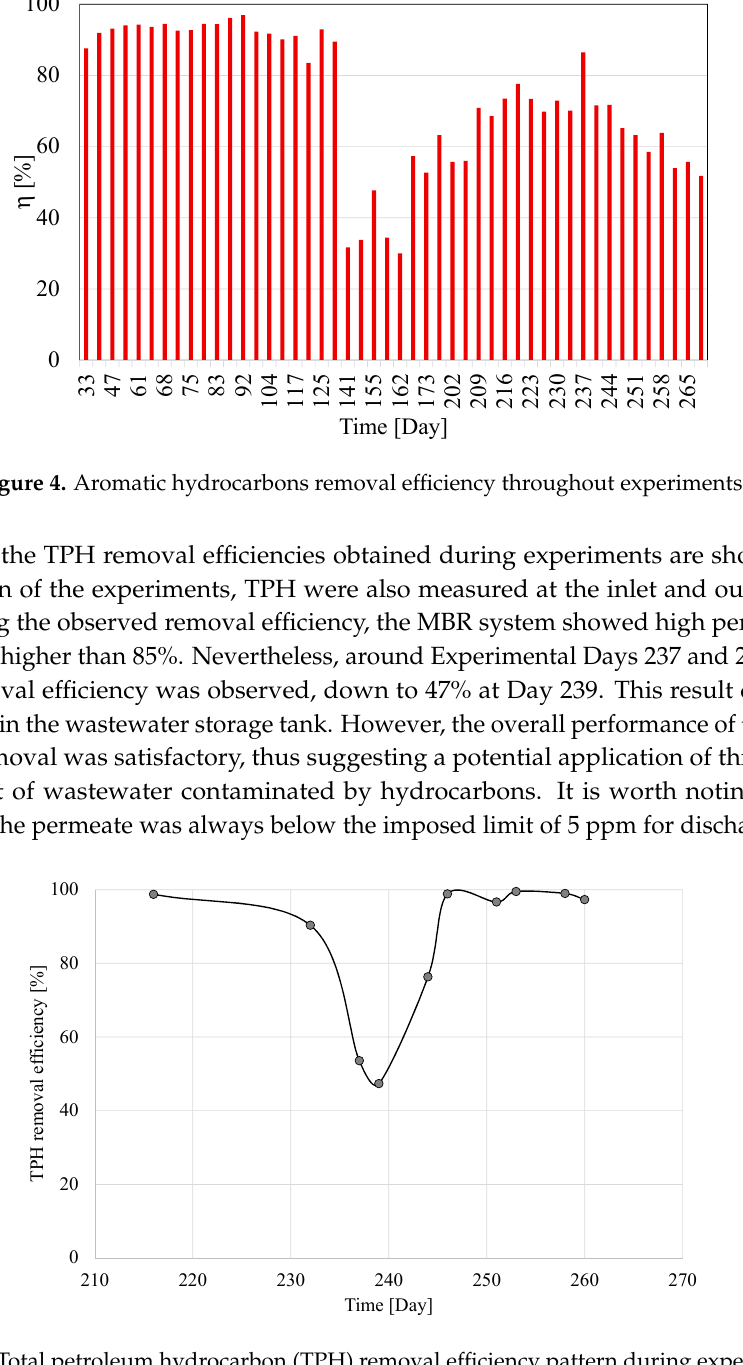
Figure 5. Total petroleum hydrocarbon (TPH) removal efficiency pattern during experiments.